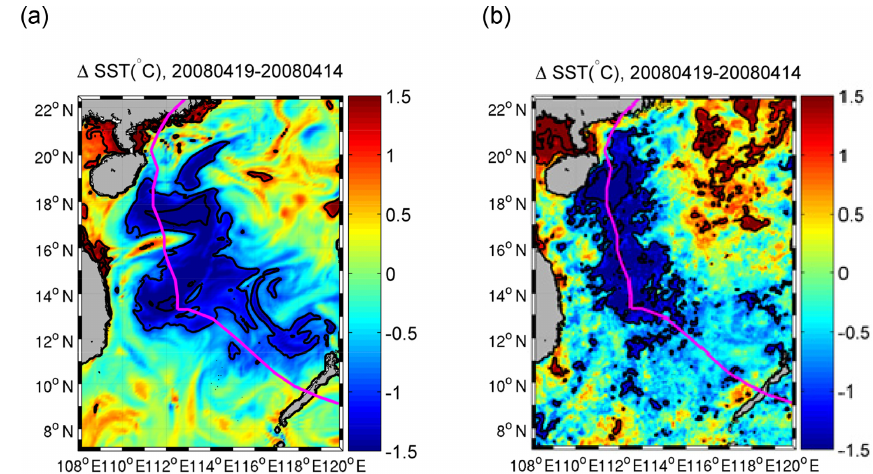
Figure 3. (cid:49) SST (19 April–14 April) from (a) model results and (b) GHRSST JPL MUR satellite products. The pink curve indicates to the trajectory of the TC Neoguri.